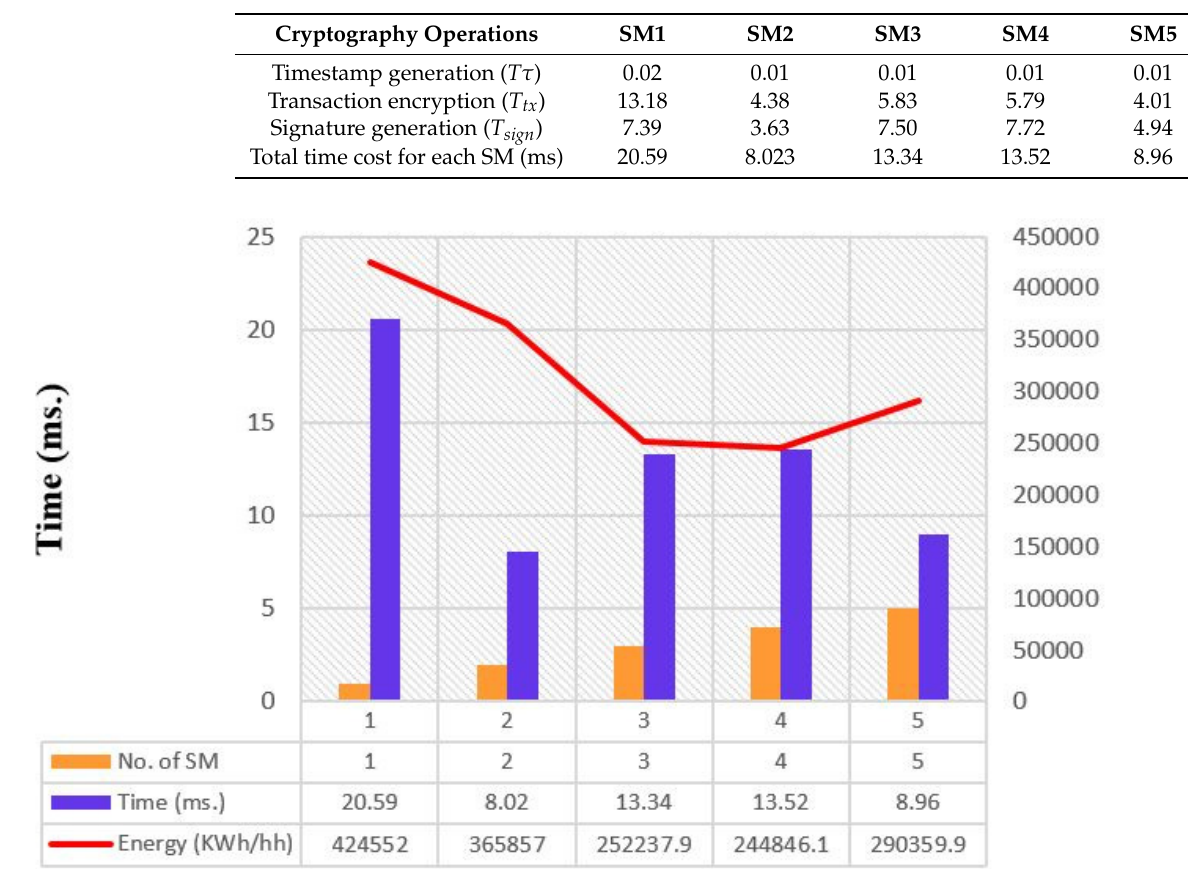
Figure 6. Time cost analysis of each smart meter for half hourly energy consumption records.